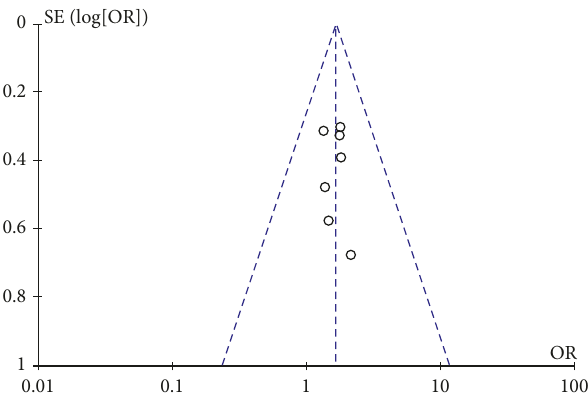
Figure 5: Funnel plot analysis of the negative conversion rate of HBV DNA in the included